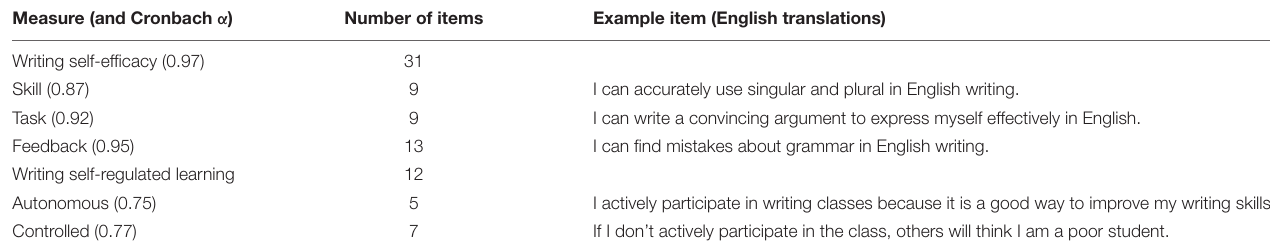
TABLE 3 | Survey measures, scale reliabilities, number of items, and example items. Measure (and Cronbach α ) Number of items Example item (English translations) Writing self-efficacy